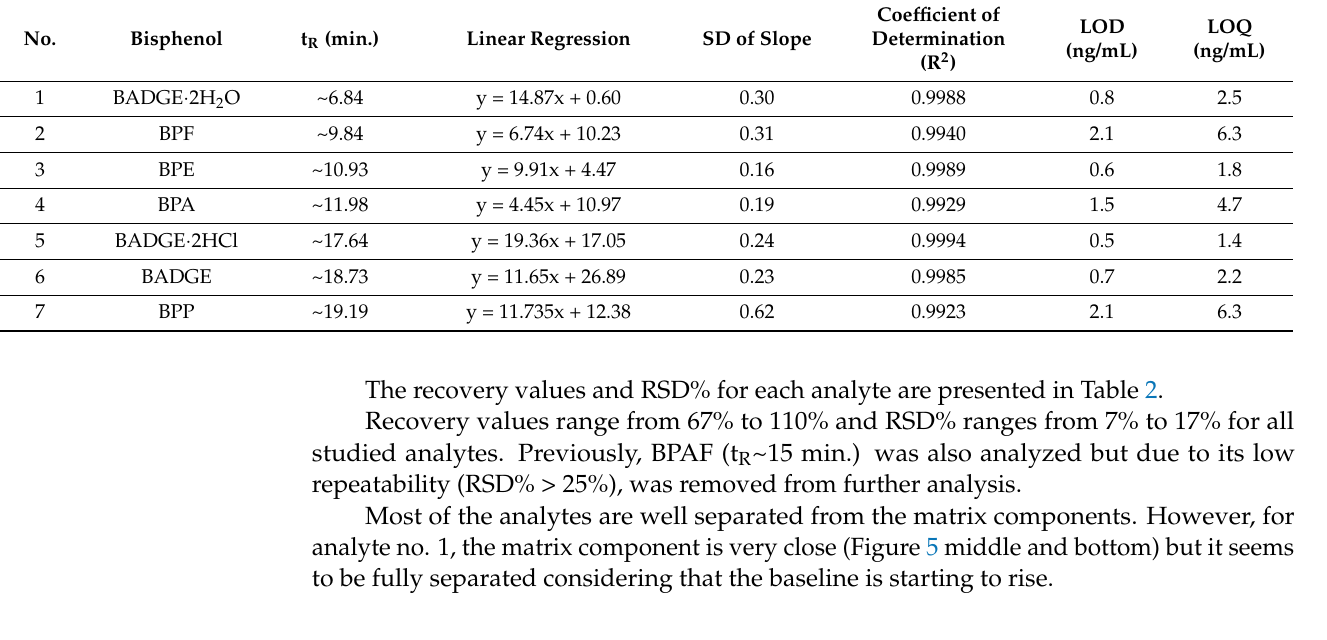
Table 1. Method validation parameters obtained from calibration curves in averaged human breast milk sample ( n = 10): time retention, linear regression, coefficient of determination, standard deviation (SD) of slope, limit of detection, limit of